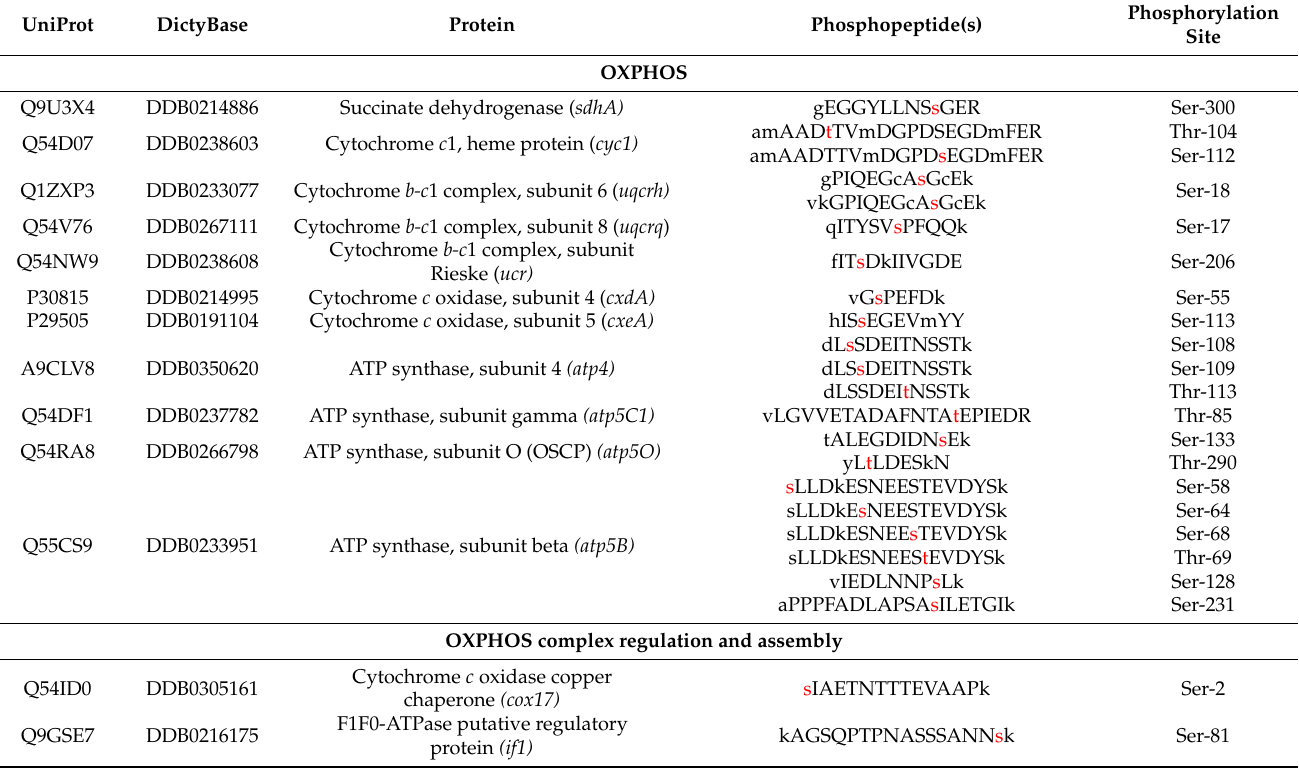
Table 1. Phosphorylated mitochondrial and mitochondria-associated proteins identified in mitochondrial preparations from D. discoideum wild-type (WT) and AMPK α -overexpressing (HPF444) strain. UniProt, Universal Protein Resource database, protein ID; DictyBase, Dictyostelium discoideum genome database, protein ID; Protein, protein name (in brackets, gene name ); Phosphopeptide(s), identified phosphorylated peptide sequence; “marked in red colour”, phosphorylated amino acid residue within the identified peptide; Phosphorylation site, phosphorylated amino acid in the protein sequence (Ser, serine; Thr, threonine; Tyr,